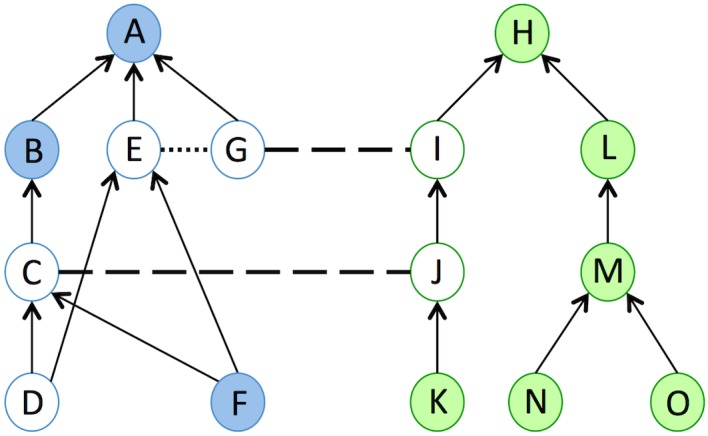
Example of an alignment between two ontologies (blue and green).Circles represent classes, arrows represent subclass relationships between classes, dashed lines represent mappings between classes, and dotted lines represent disjointness restrictions between classes. The circles filled in white represent the classes in the core fragments of the ontologies given the alignment.